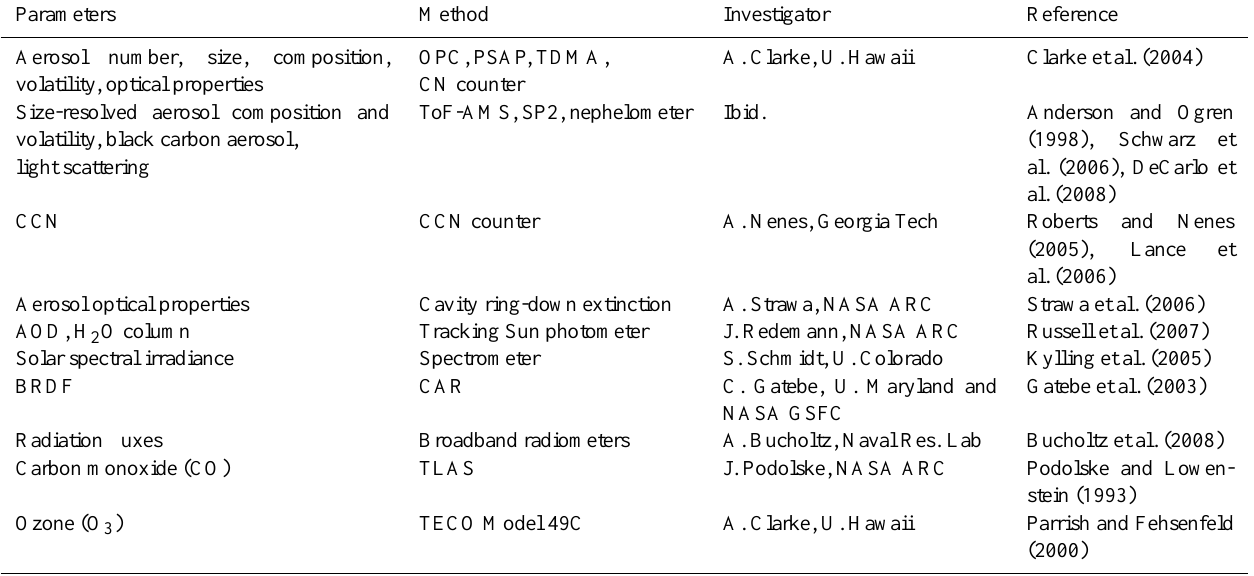
Table 3b. P-3 research payload in ARCTAS.